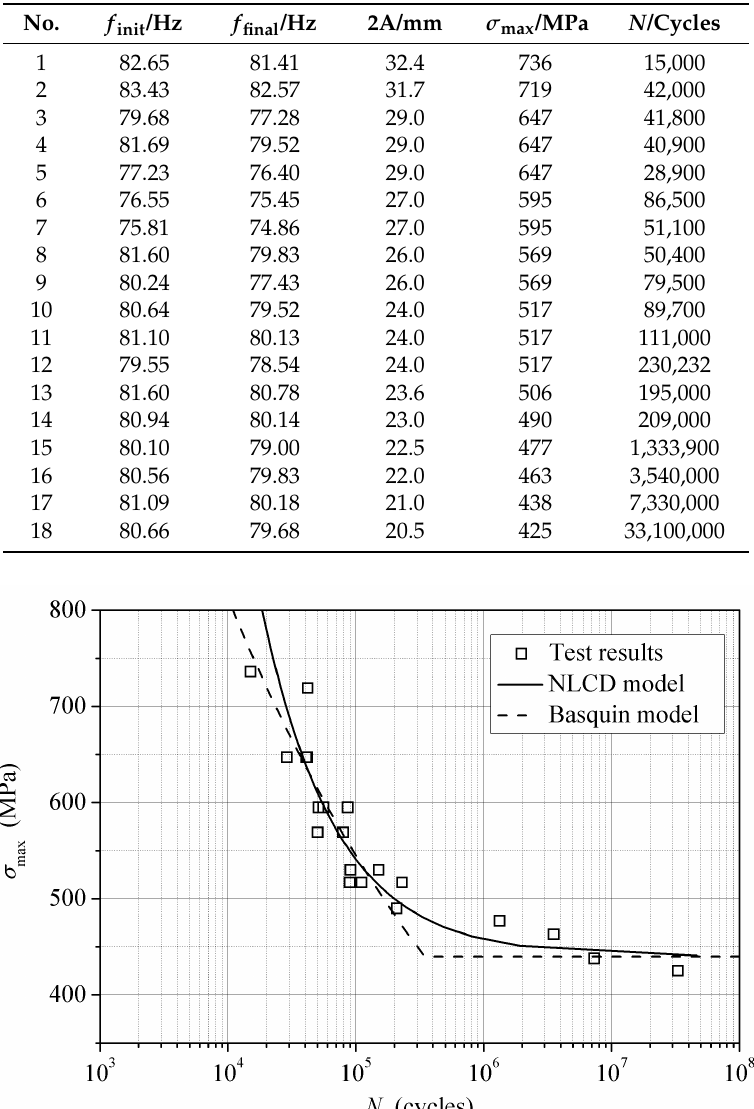
Table 1. Constant amplitude vibration (CAV) test results.